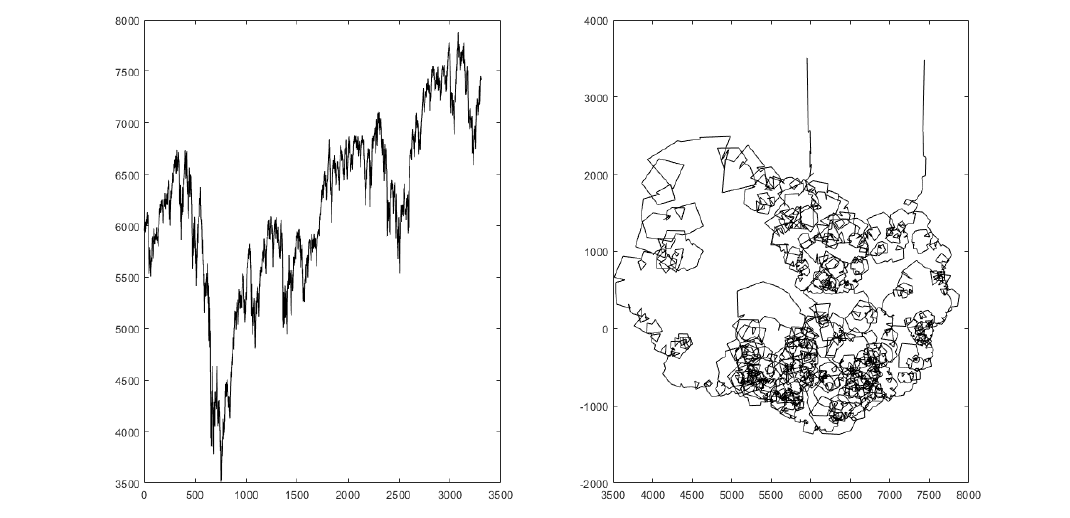
Figure 3. Example of Lévy flights. Left : Plot of the FTSE100 daily prices from 14/03/2006 to 12/04/2019— u ( t ) ; Right : Complex plane plot of s ( t ) given by Equation (16). Both time functions u ( t ) and s ( t ) are taken to be uniformly sampled discrete functions u n and s n , respectively; the analytic signal is computed using a fast Fourier transform (FFT) and the algorithm presented in